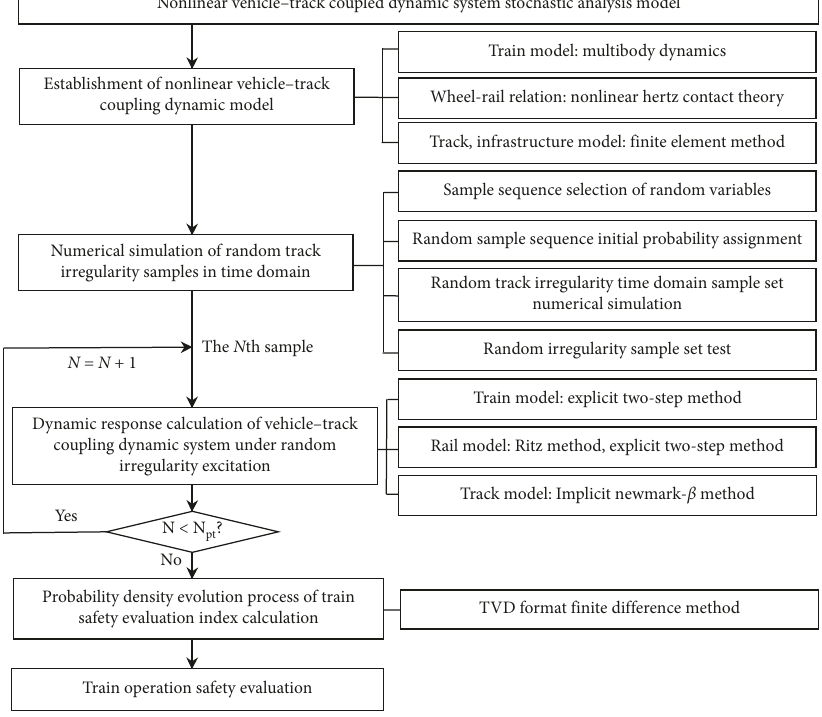
Figure 1: Flow chart of the method for evaluating train operation